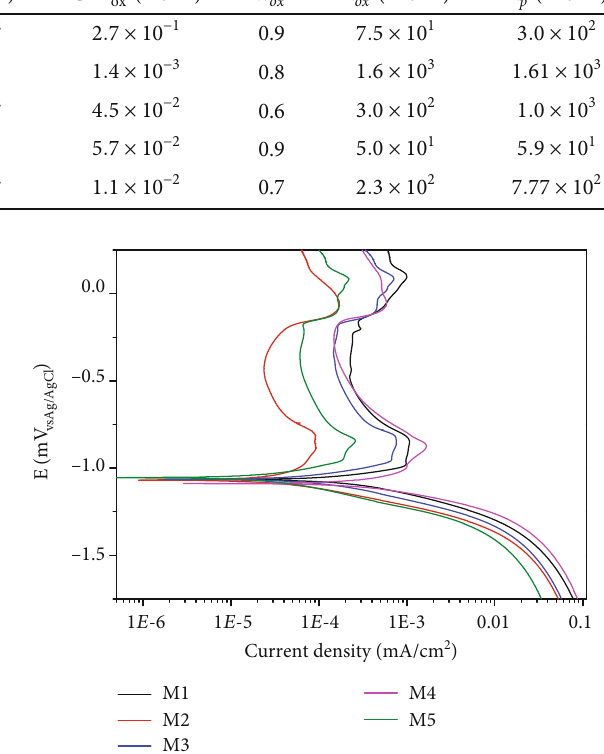
Figure 8: Polarization curves for aluminum-based alloy doped with Mn and Co as cast immersed in 3M KOH.